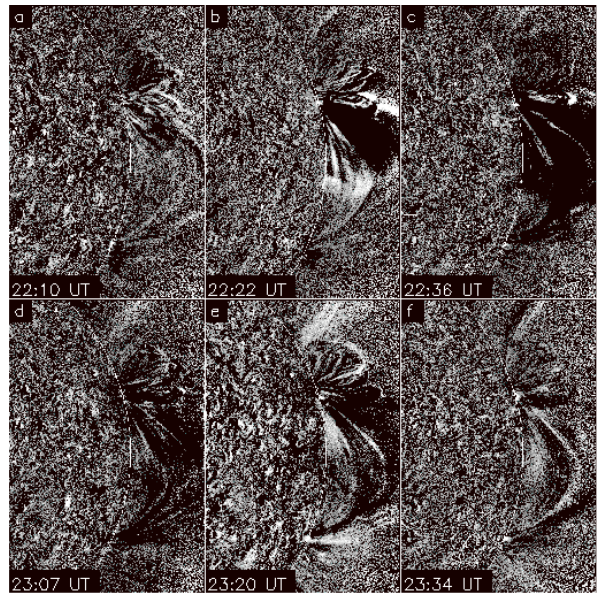
Fig. 7. From Glover et al. (2003) showing how low-coronal dimming evolves and spreads due to the involvement of a trans- equatorial loop system (TEL) in the CME process on 29 May 1998. EIT 195 ˚A difference images show that a dimming appears first around the flaring AR in the north, then gradually spreads along the TEL while its distant footpoint brightens and an SXR cusp ap- pears above the TEL, suggestive of the post-“opening” reconnection process. Flaring behaviour of a TEL has also been found by Harra et al.